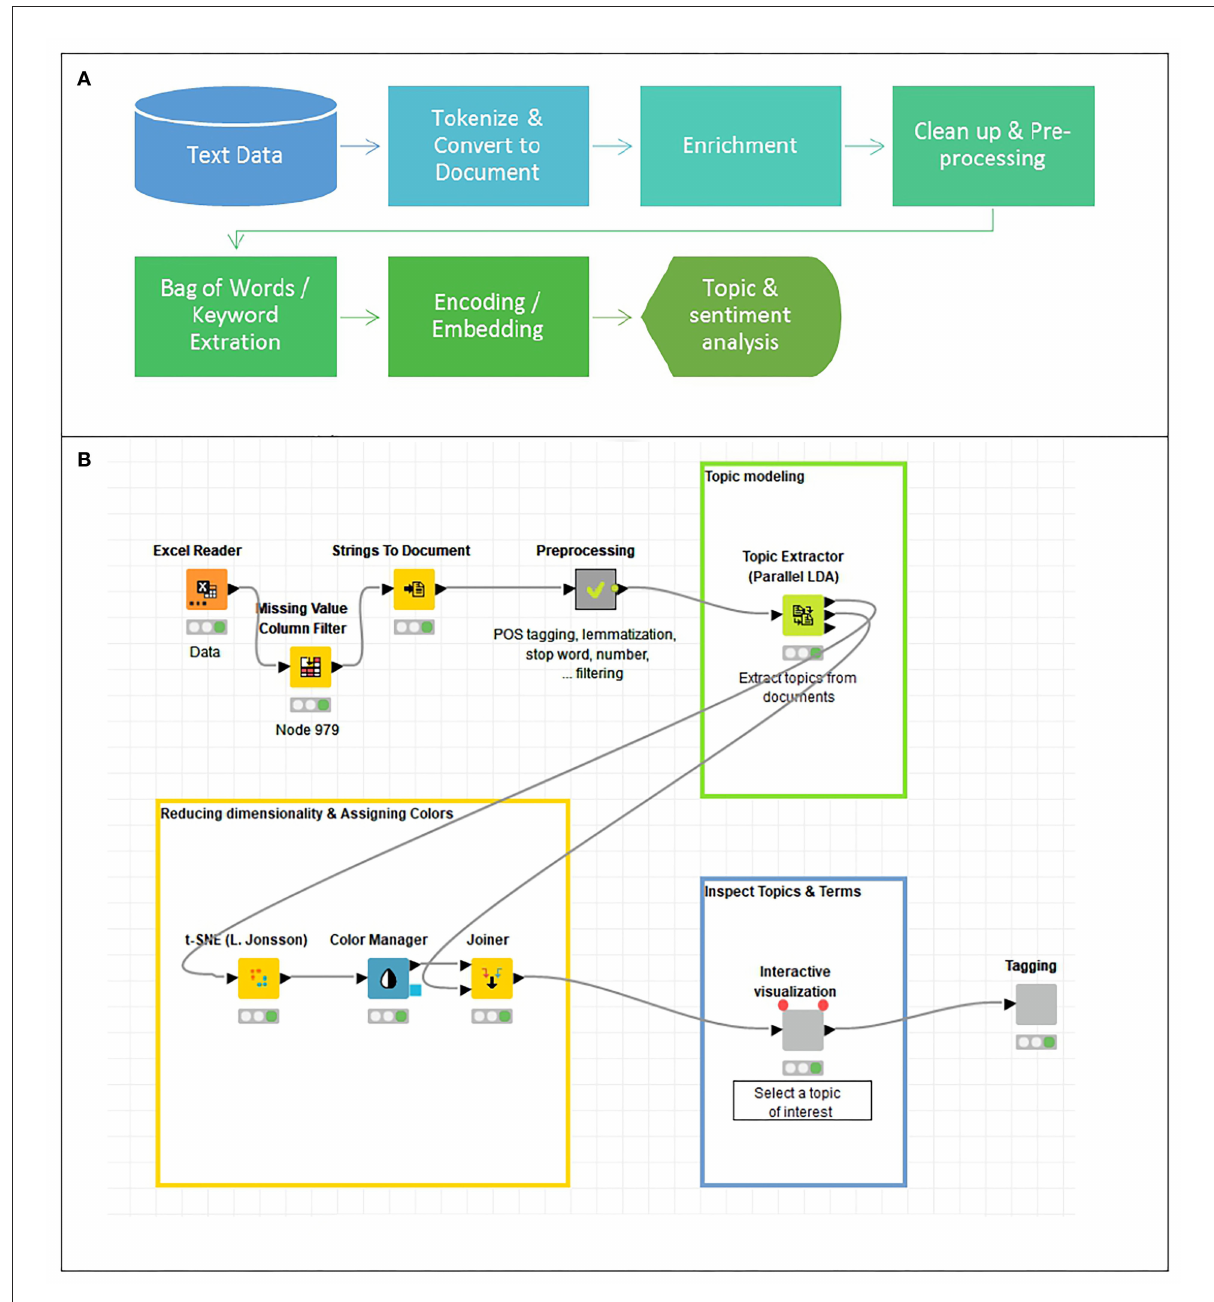
FIGURE6 (A) Co-occurrence of words in a flow-diagram and (B) Co-occurrence of words in Keyword Plus from all